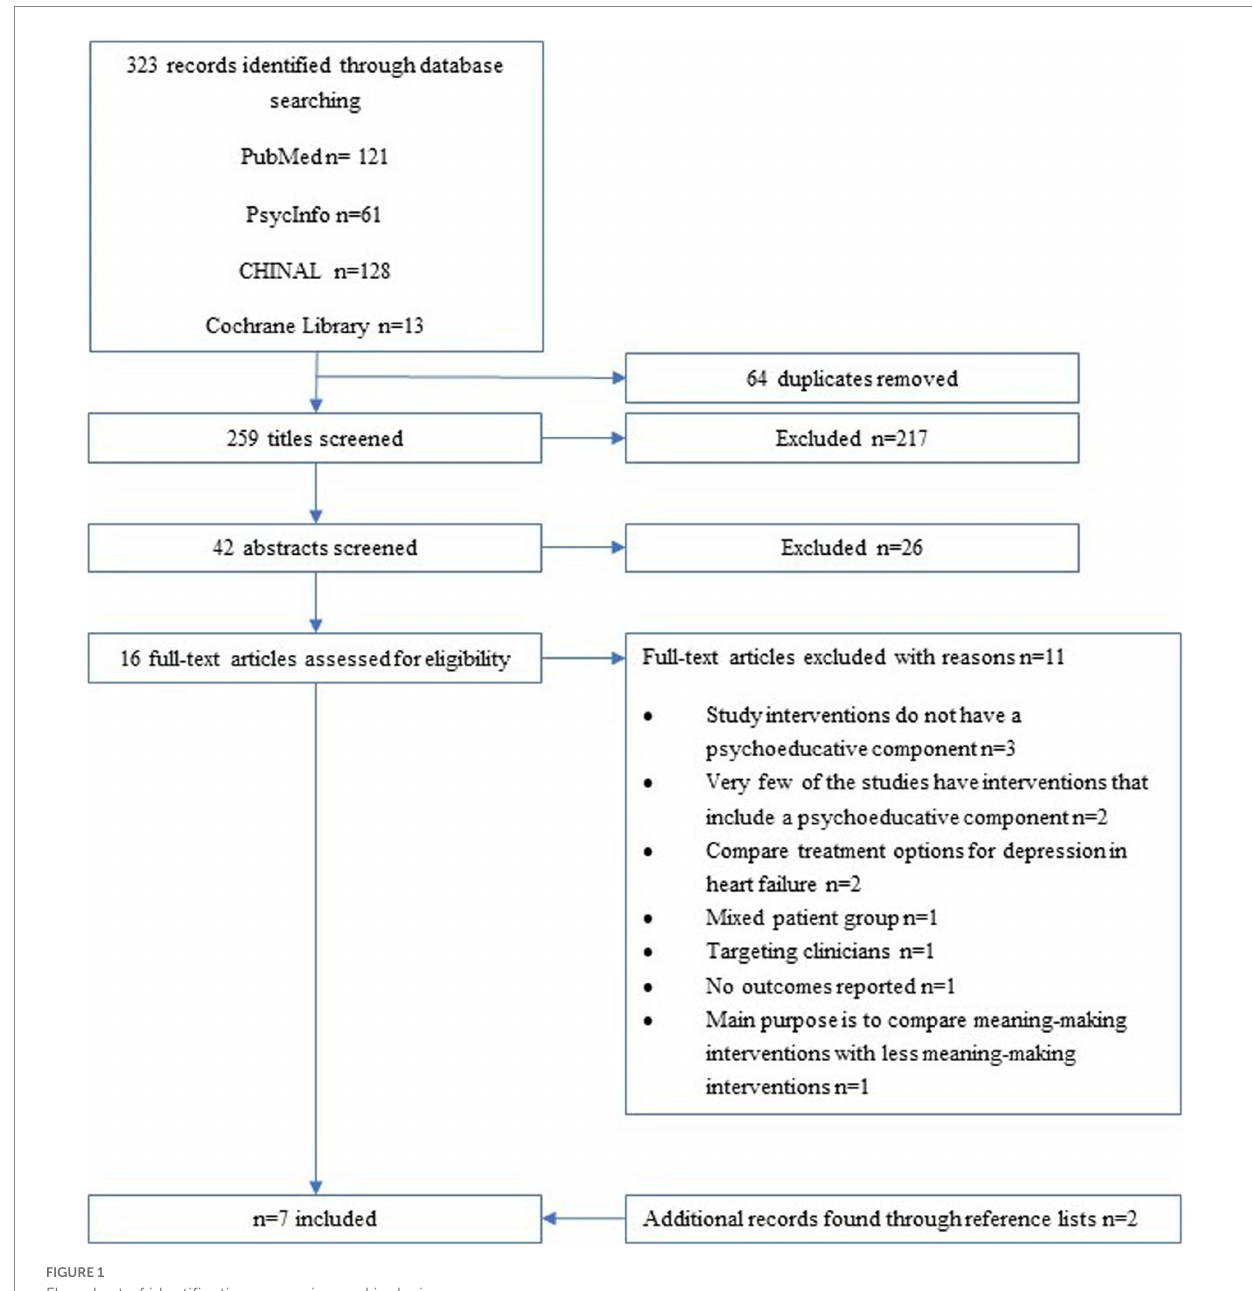
FIGURE 1 Flowchart of identification, screening and inclusion